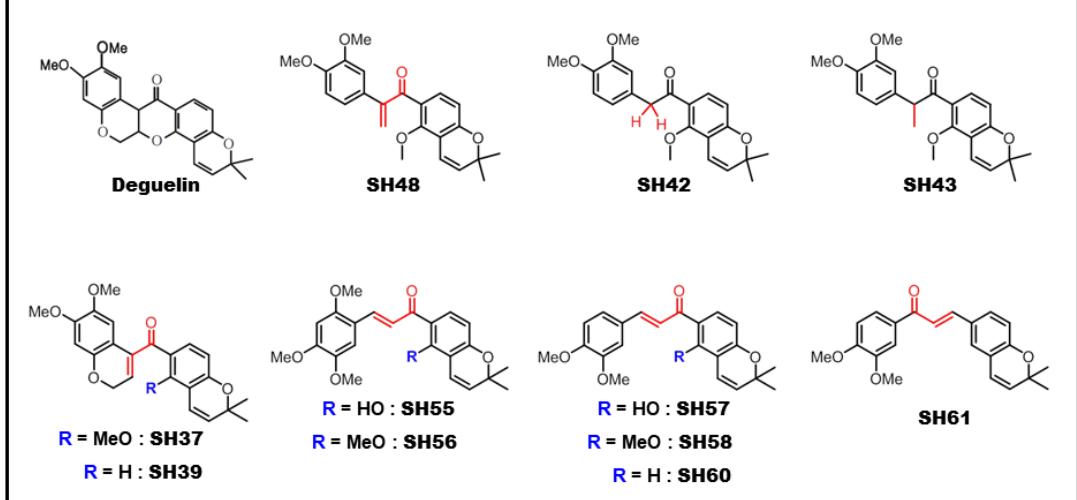
Biomedicines 2020 , 8 , x FOR PEER REVIEW Figure 1. Chemical structures of synthetic deguelin and its synthetic derivatives tested in this study. STAT3 phosphorylation at the tyrosine 705 residue facilitates STAT3 dimer formation, leading